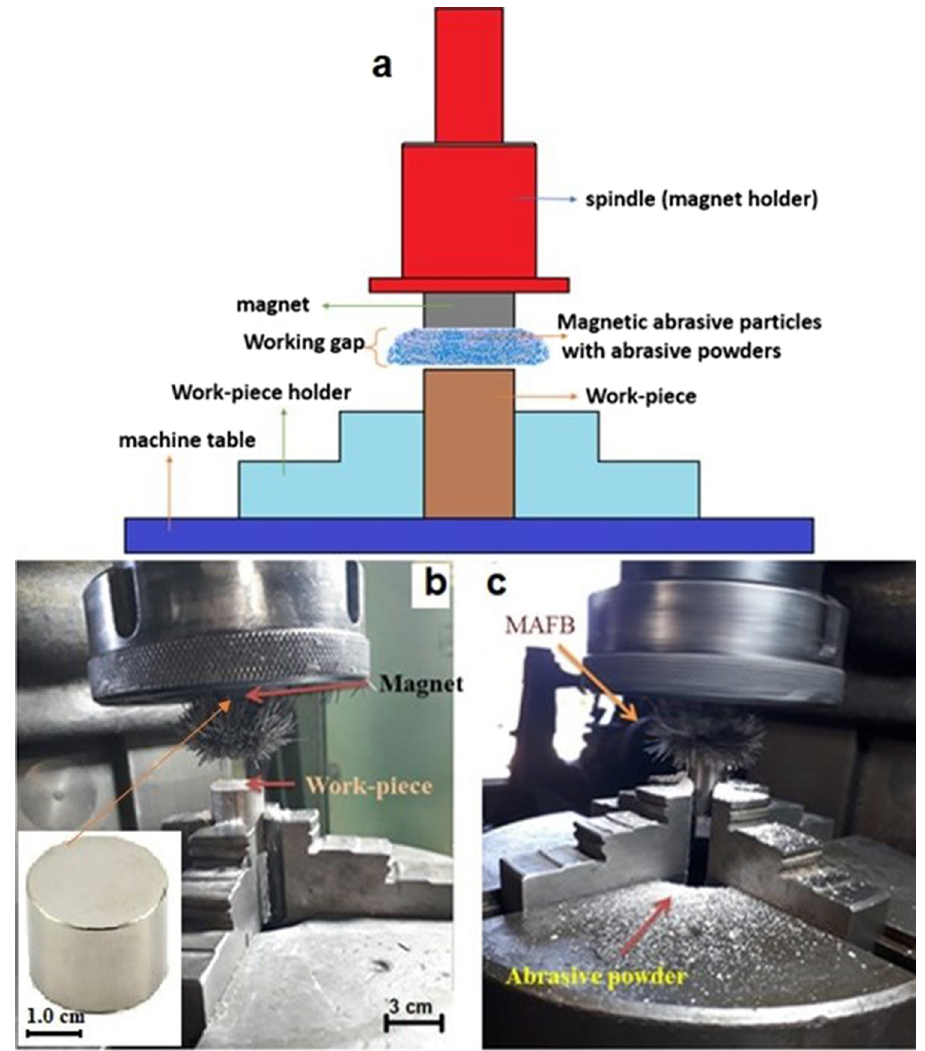
Fig. 2. Experimental setup of MAF process (a) Schematic, (b) Initial state, (c) During the